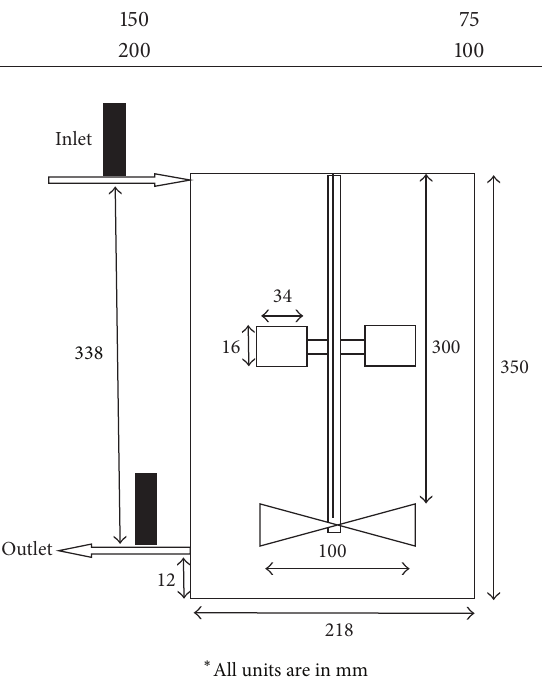
Figure 1: Schematic diagram of Type A mixing vessel rig for radiotracer